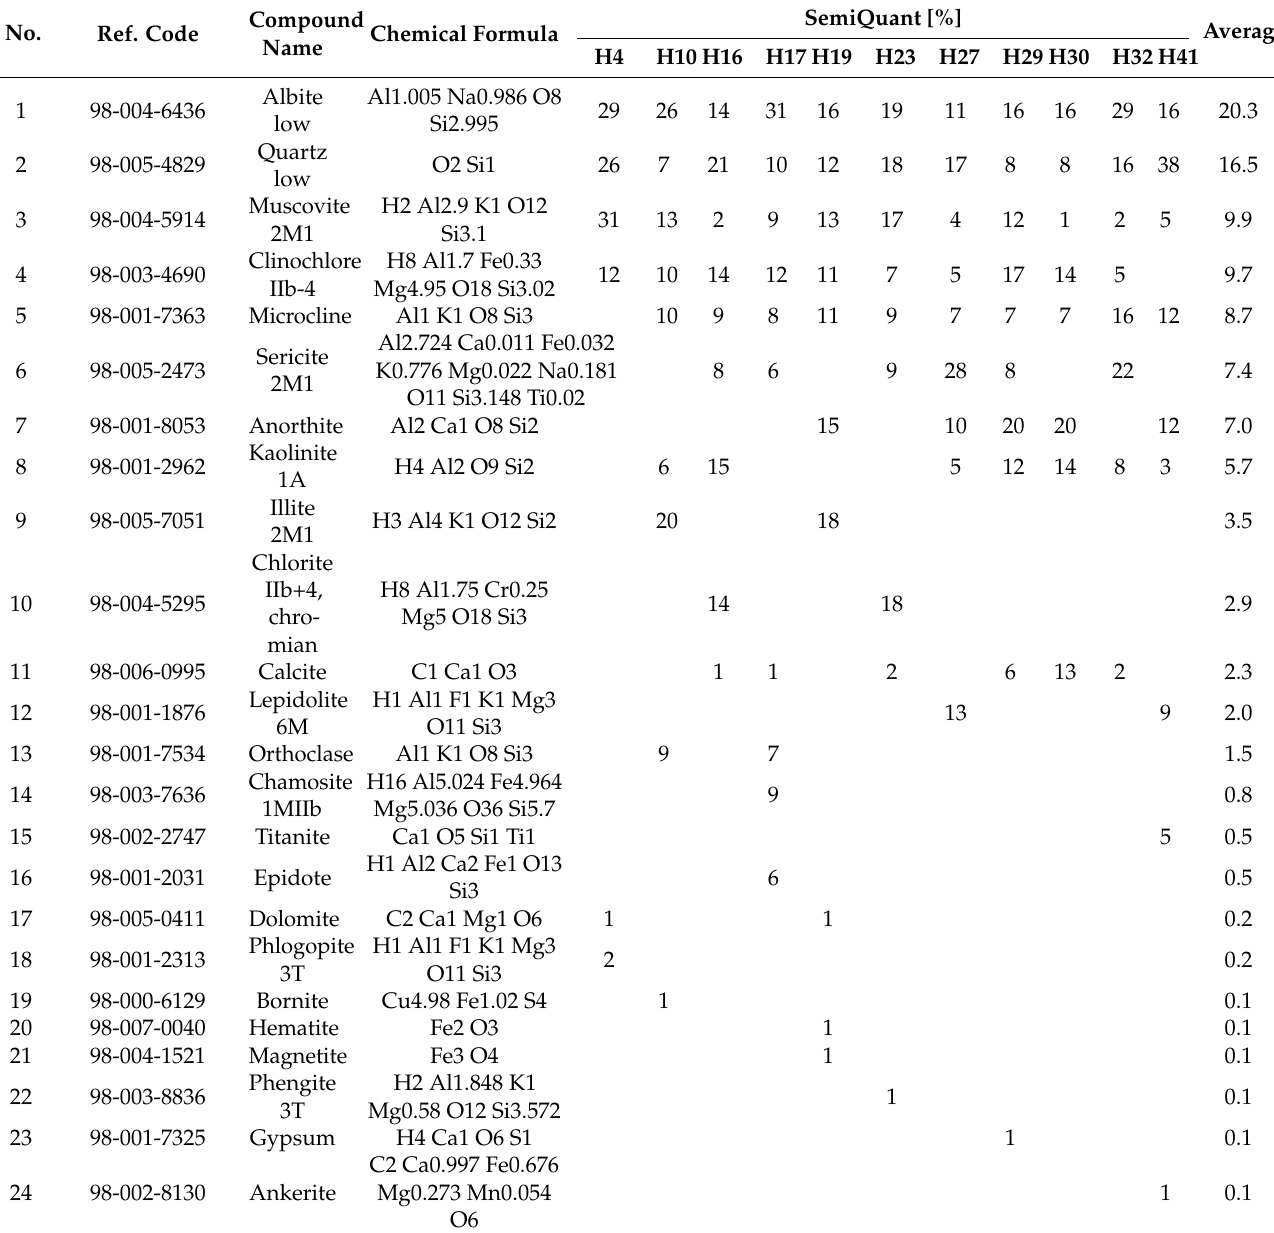
Table A3. XRD analyses of representative samples from alteration zone-2 (calcite–epidote–albite ± chlorite ±